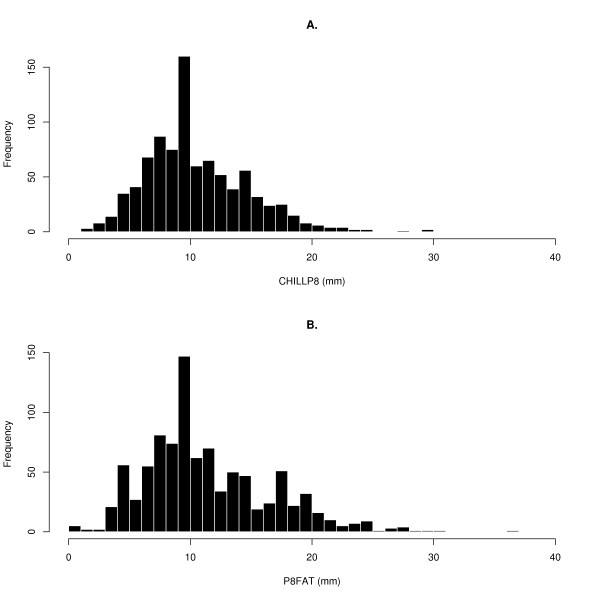
Distribution of trait measurements in the sample. A. Histogram of CHILLP8 fat thickness for animals in the GWAS sample. Note the excess frequency at 10 mm, B. Histogram of P8FAT thickness for animals in the GWAS sample, note the excess frequency at 10 mm and that the distribution appears less smooth than the CHILLP8 distribution.